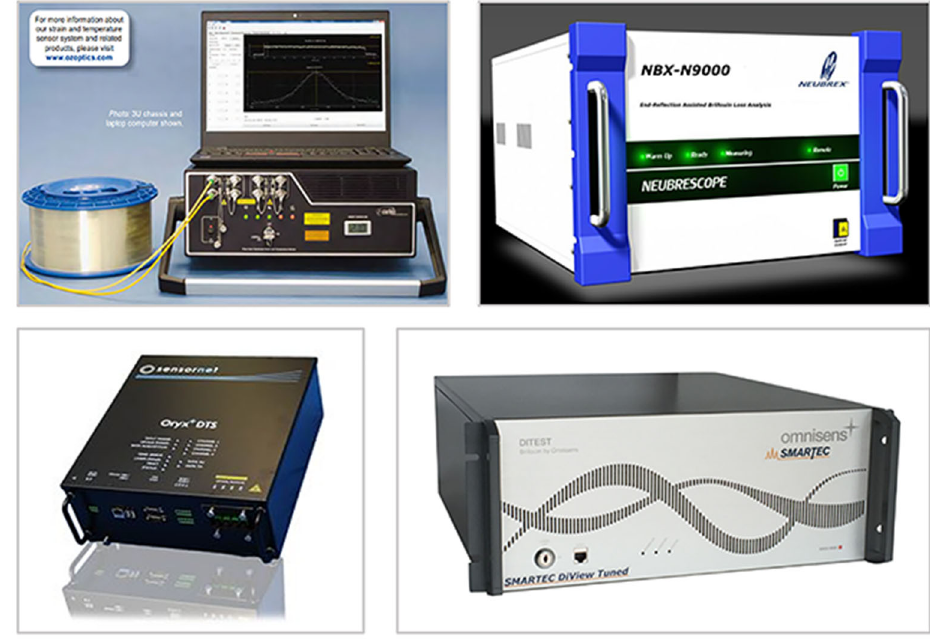
Figure 11. Several commercial DOFS optoelectronic devices